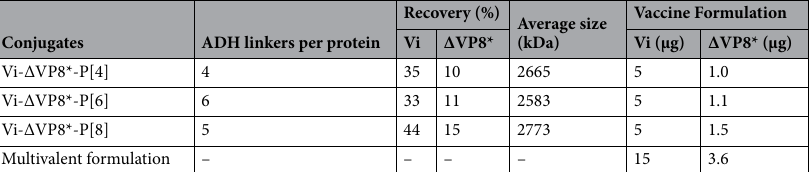
Vaccine Formulation Recovery (%) Average size (kDa) Vi